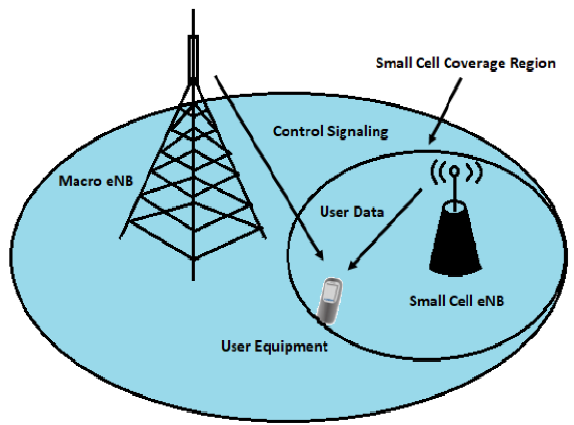
Figure 1. Dual connectivity of user equipment (UE) with macro eNB and small-cell